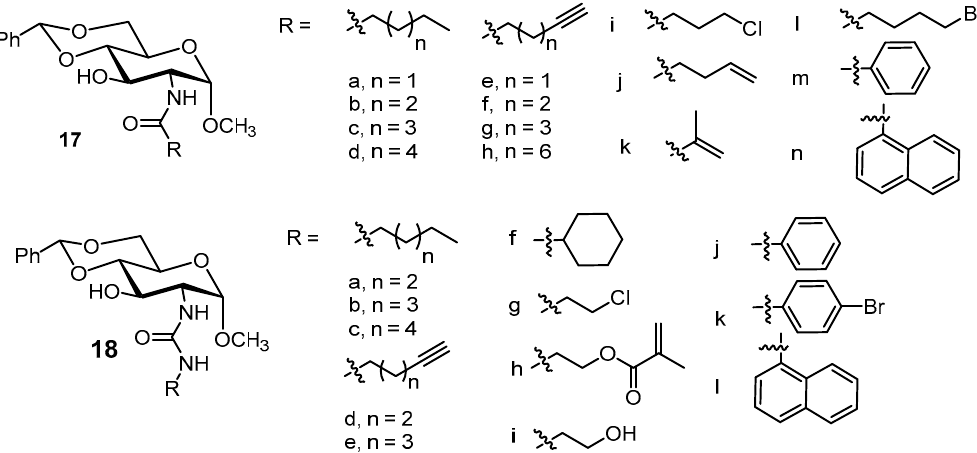
Figure 10. Sugar-based gelators containing amide and urea functions [33], n (in the formula) represents the number of repeating CH 2 .